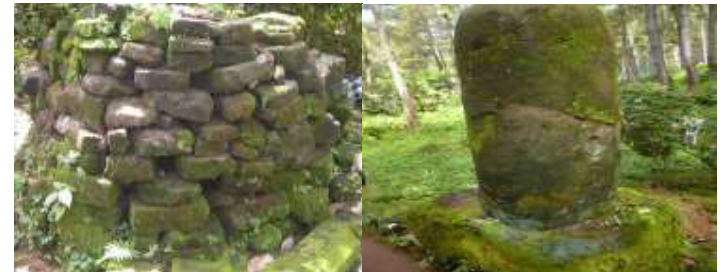
Figure 1. Megalithic Stone and Yoni Lingga